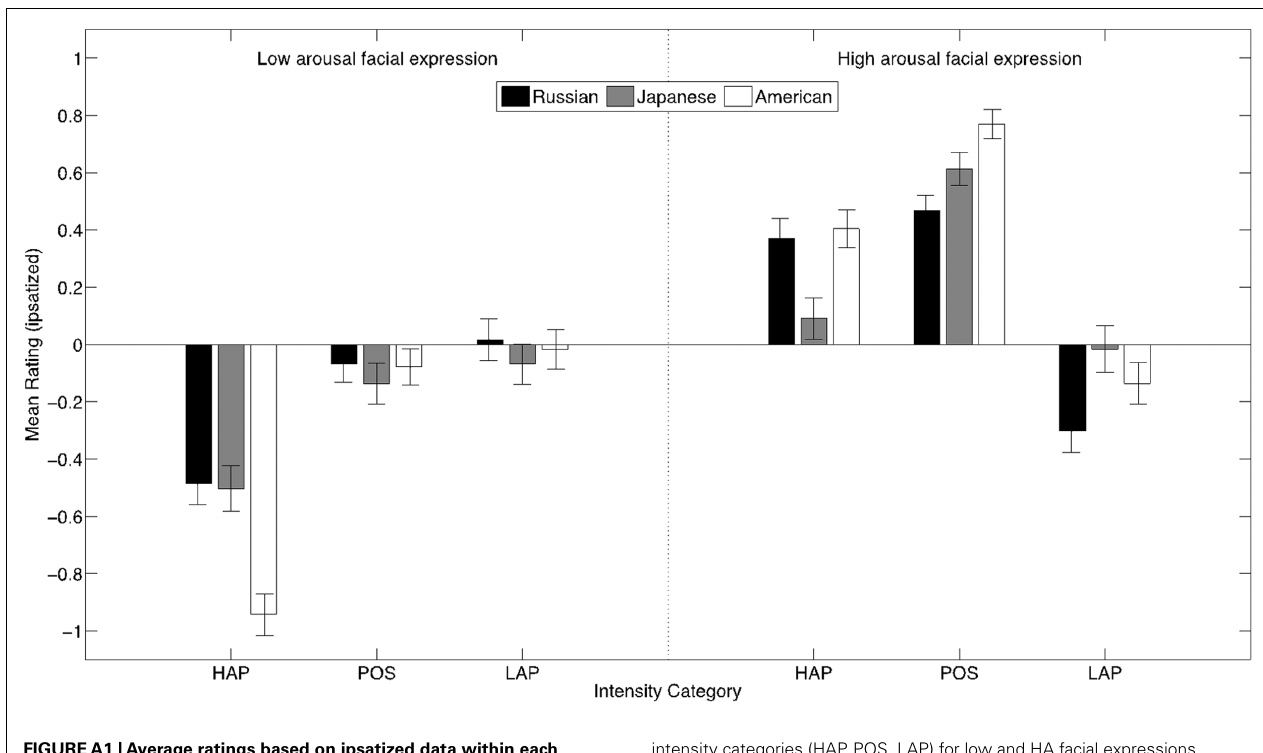
FIGUREA1 |Average ratings based on ipsatized data within each intensity category for advertisements showing LA and HA facial expressions across cultures. FigureA1 shows mean ratings based on ipsatized data across cultures (Russian, Japanese, American) and emotion